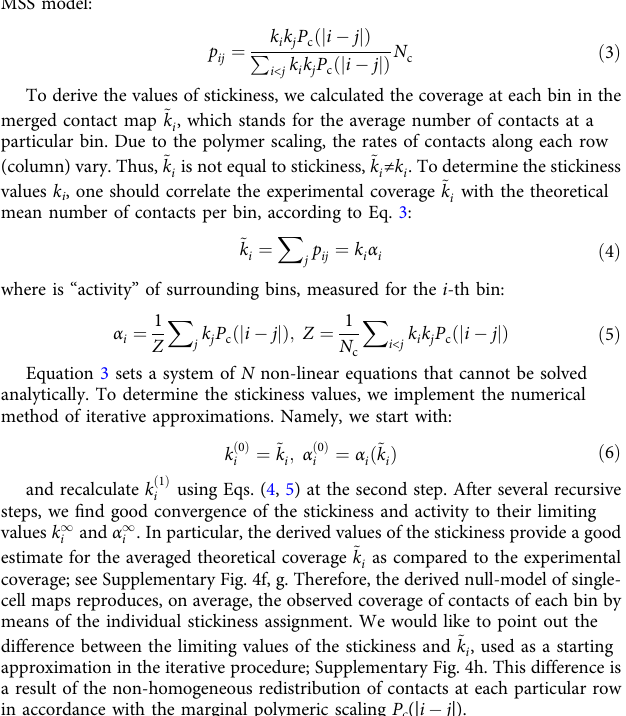
dRING binding data were obtained from modENCODE as a ChIP-chip normalized array fi le (ID 927 54 ). We considered the pairs of potential looping positions cor- responding to intrachromosomal interactions, at the genomic distances of more than 600 kb, separated by up to 50 other looping positions. The snipping of Hi-C square 600-kb windows, centered on the corresponding looping positions, was done with cooltools (https://github.com/mirnylab/cooltools/tree/master/cooltools). The aggregation was performed by summation. log 10 values were plotted as